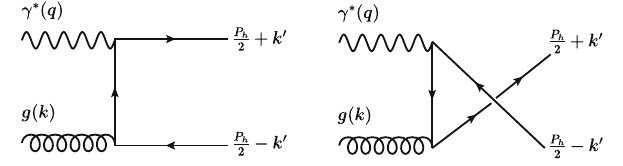
Fig. 11 Feynman diagrams for γ ∗ + g → J /ψ